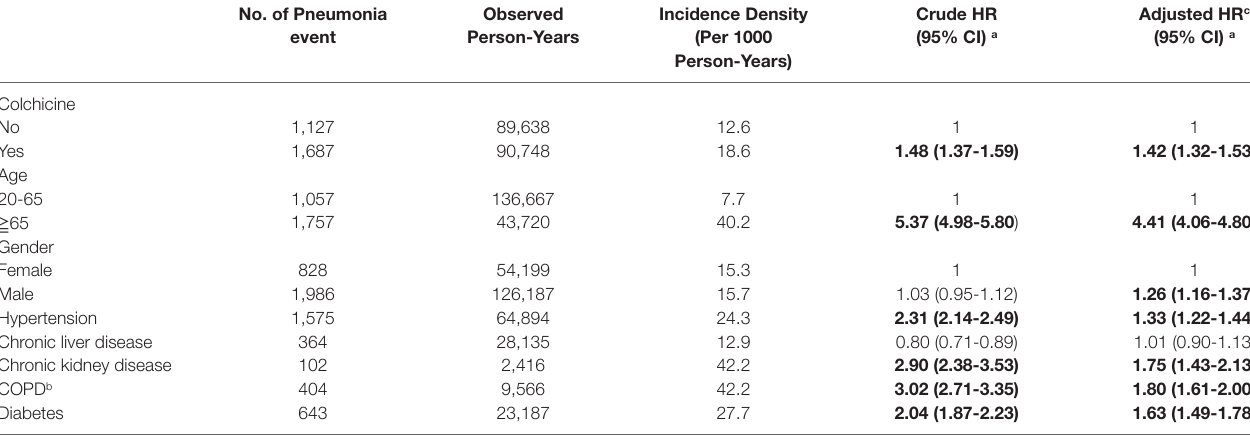
TABLE 2 | Analysis of factors affecting pneumonia risk in gout patients treated with and without Colchicine by Cox proportional hazard